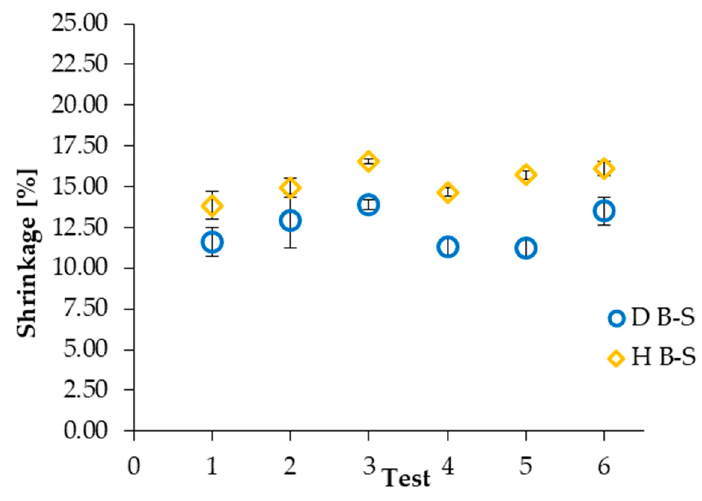
Figure 9. Diameter and height shrinkage from brown to sintered bodies.